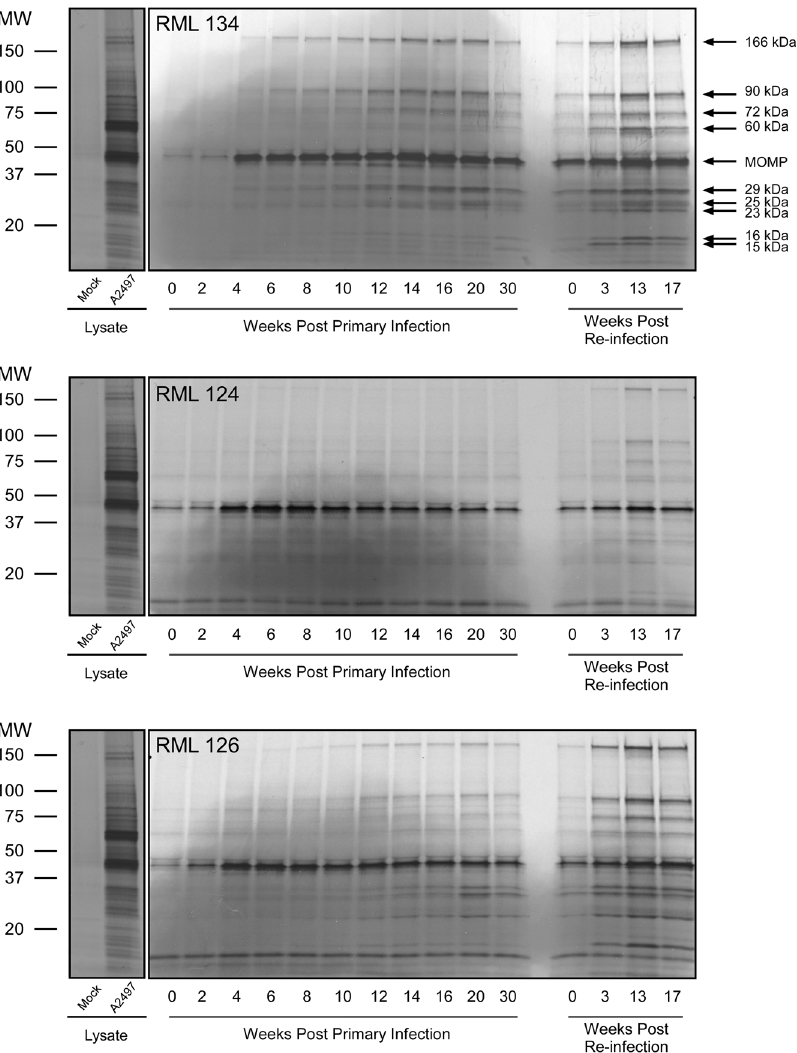
Figure 1. Antibody signature of C.trachomatis infected macaques following primary infection and re-challenge. Three monkeys were infected ocularly with C. trachomatis strain A2497 [7]. Monkeys cleared the infection 9–14 wpi (RML134: 13 wpi; RML124: 8 wpi; RML126: 14 wpi). Clinical disease remained severe to moderately severe during the periods of culture positivity and continued until about 30 wpi. Three months after resolution of disease monkeys were re-challenged and all monkeys exhibited partial protection characterized by a more rapid clearance of organism (3–7 wpi) with an accompanying reduction in the intensity and duration of ocular inflammation (11 wpi). Sera collected from monkeys during primary infection and following re-challenge were analyzed by RIP using intrinsically labeled chlamydial proteins prepared from non-denaturing detergent lysed infected McCoy cells. Sera from all three macaques produced a similar yet simple antigen recognition profile that differed in complexity over the period of primary infection and re-challenge. A total of 10 proteins were immunoprecipitated with molecular masses of 166, 90, 72, 60, 40, 29, 25, 23, 16 and 15 kDa. There was a noticeable temporal and recall recognition pattern of the antigens in all three monkeys. The MOMP (40 kDa) recognition was strong very early post infection (2–4 weeks) and consistently sustained throughout the entire period of infection and disease. In contrast immunoprecipitation of the other chlamydial proteins occurred later following primary infection, with the strongest immunoprecipitation reactions occurring at the time of infection eradication and disease resolution. There was a recognizable increase in the immunoprecipitation of all of these proteins by all three animals following re-challenge.